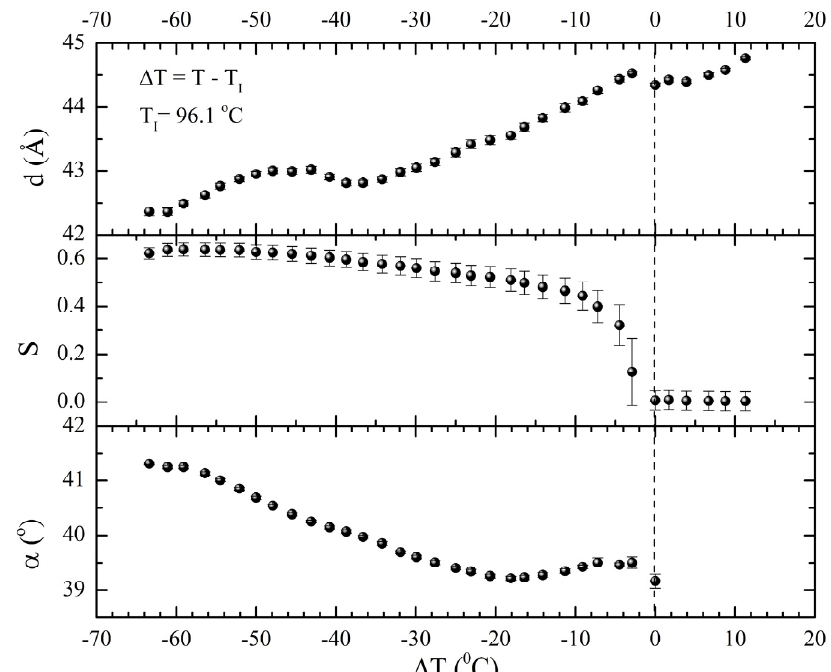
Figure 17. LCE1: Length Recovery: Temperature dependence of d and S for the hydrocarbon part and the angle α are shown as function of the distance ∆ T = T − T the clearing point, while the elastomer is slowly heated from the non-elastic irreversible state at room temperature to the isotropic state above temperature T polydomain state is